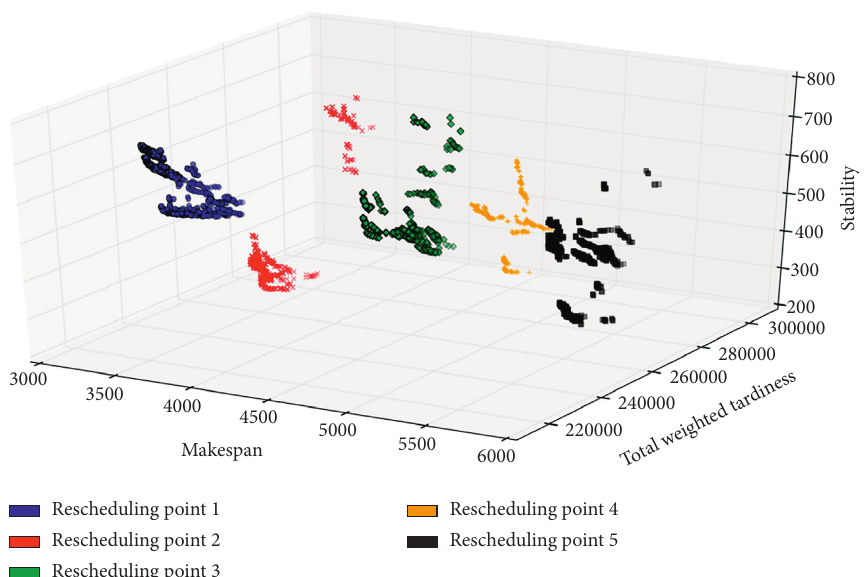
Figure 8: RIPG Pareto front in TA_50_5_4.